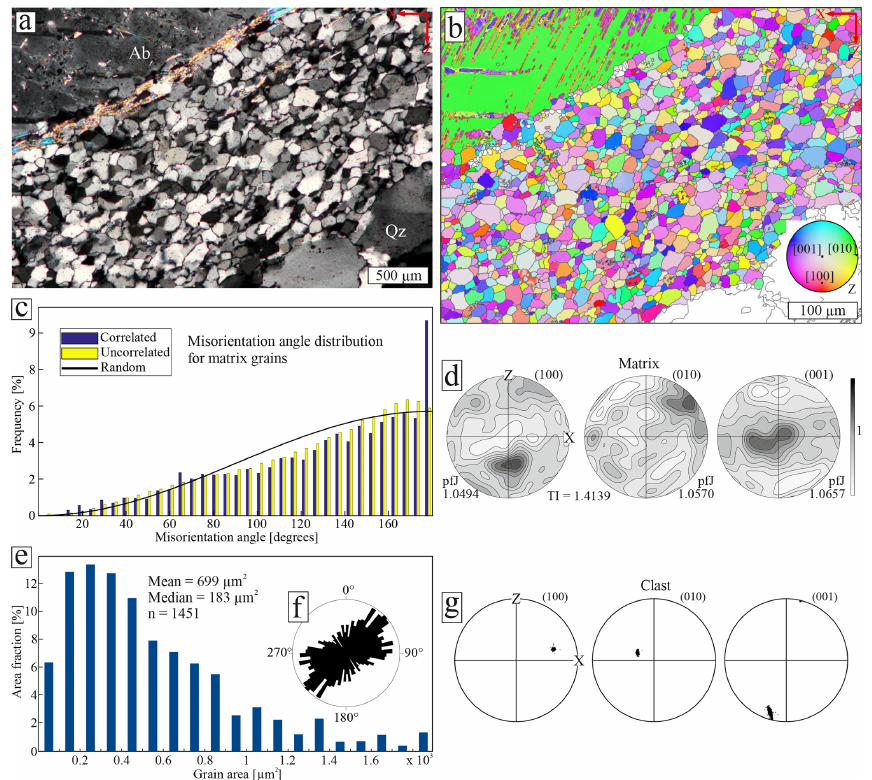
Figure 10. EBSD-analysis of type A albite matrix in sample FH5. (a) Photomicrograph of the analysed area. (b) EBSD map with inverse pole figure colouring (see lower inset). Twin boundaries in the porphyroclast are shown as red lines. (c) Misorientation angle distribution showing an essentially random distribution of neighbouring or random grain pairs. (d) Contoured pole figures showing orientation distribution of albite matrix grains. (e) Grain area distribution of the measured matrix grains. (f) Rose diagram showing the orientation of the long axis of grains. (g) Pole figures showing the orientation of the albite porphyroclast from panels (a, b)